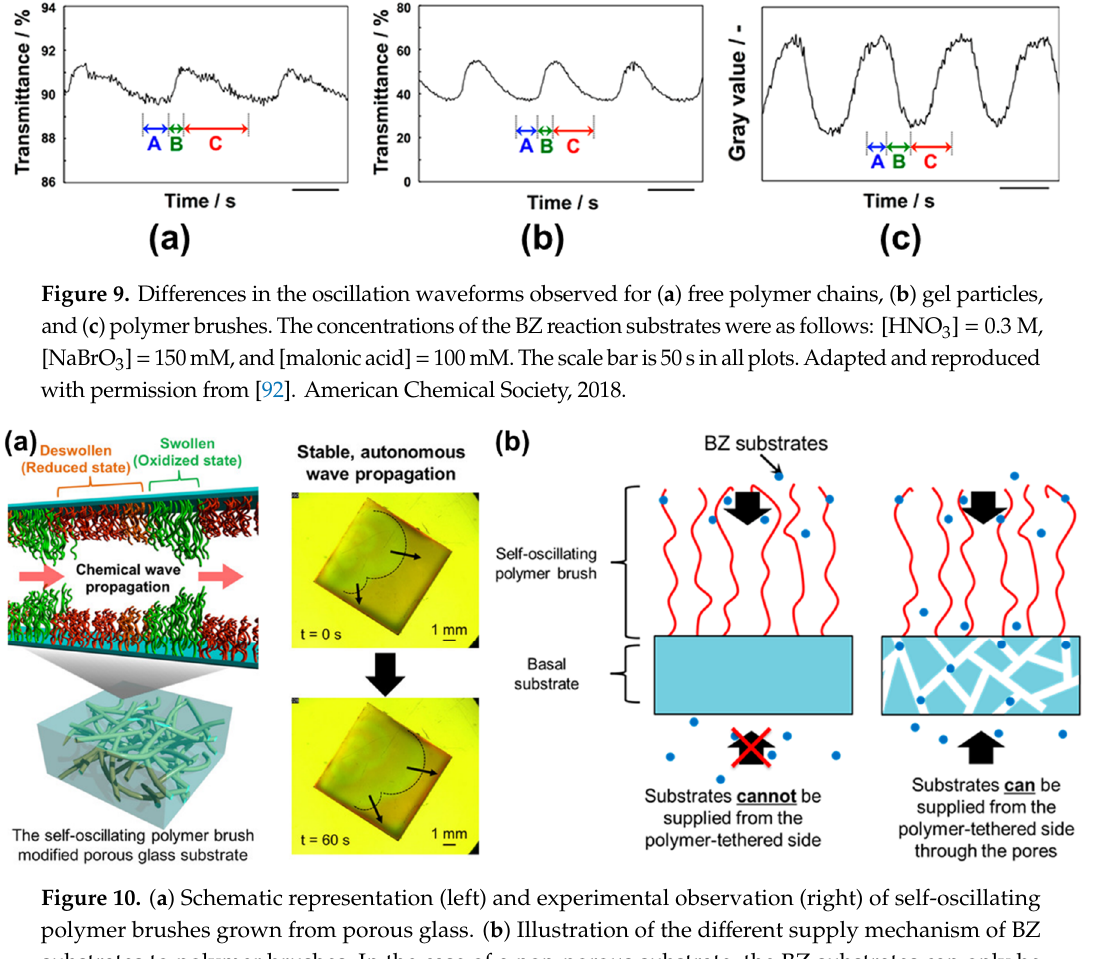
Figure 9. Differences in the oscillation waveforms observed for ( a ) free polymer chains, ( b ) gel particles, and ( c ) polymer brushes. The concentrations of the BZ reaction substrates were as follows: [HNO 3 ] = 0.3 M, [NaBrO 3 ] = 150 mM, and [malonic acid] = 100 mM. The scale bar is 50 s in all plots. Adapted and reproduced with permission from [92]. American Chemical Society, 2018.